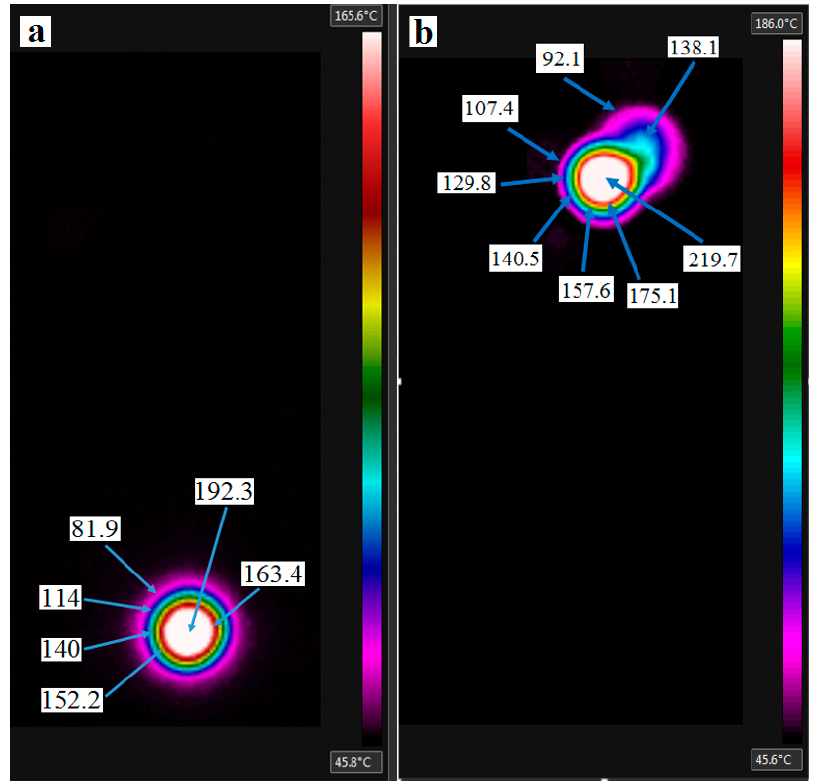
Figure 6. Maximum temperature readings when drilling GLARE 2B 11/10 at ( a ) 6000 rpm and 300 mm/min using MQL; ( b ) 9000 rpm and 900 mm/min showing burr cap separation under dry conditions.